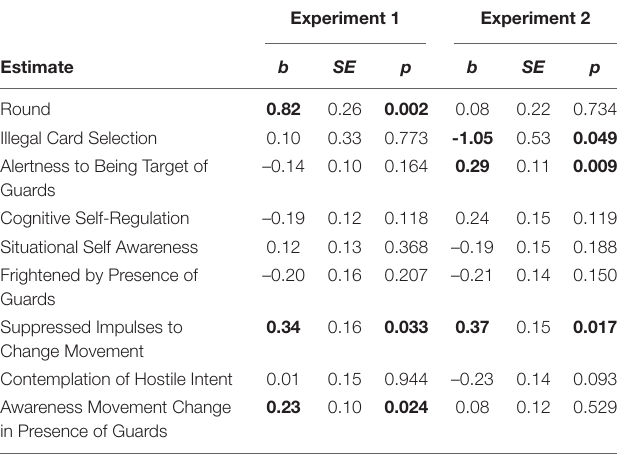
TABLE 6 | Regression beta, SE, and P -values for variation route deviation as dependent